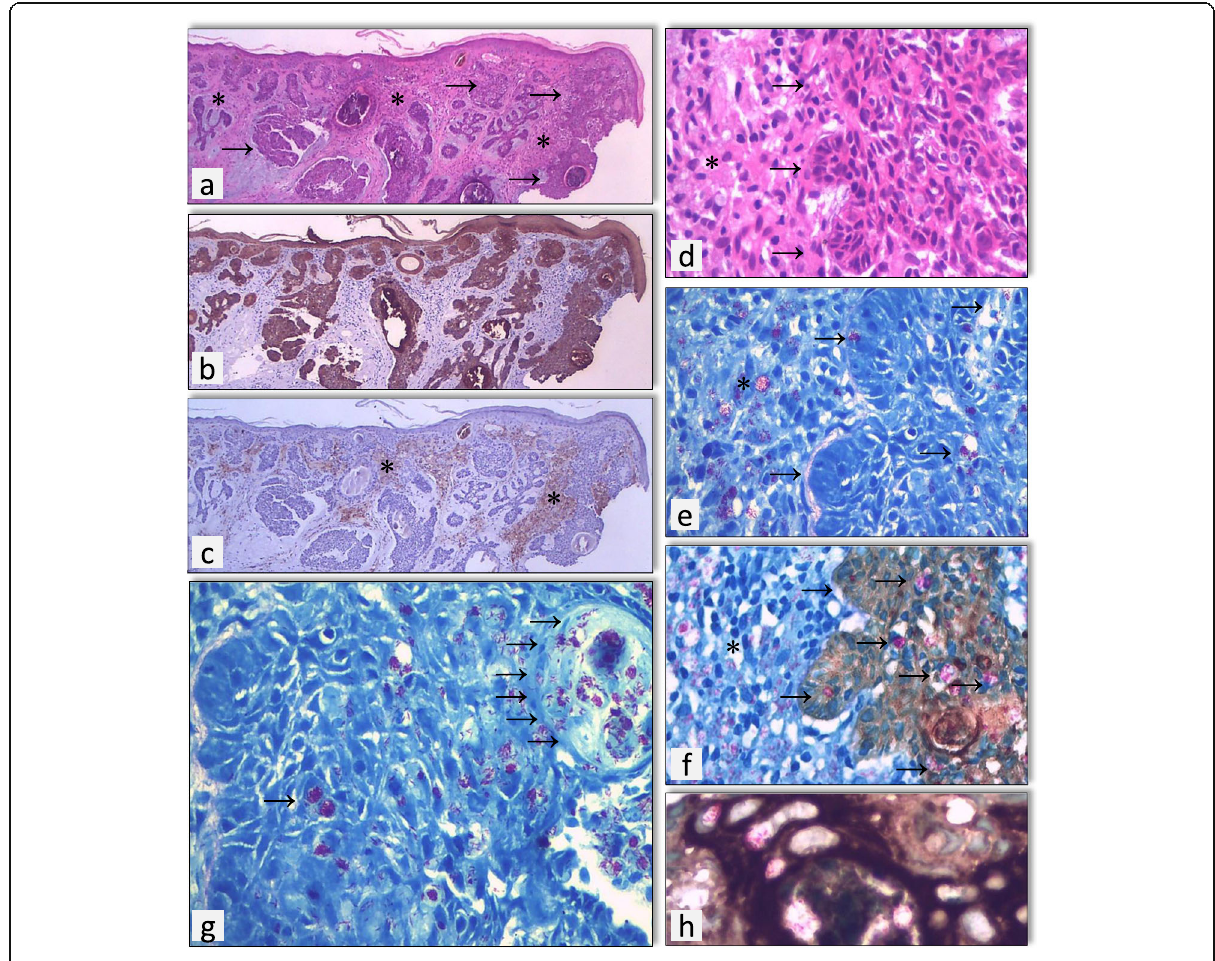
Fig. 4 Parasitism of basal cell carcinoma by M. leprae in case 3. Sequential sections stained with hematoxylin-eosin (HE) ( a ) and immunohistochemistry (IHC) ( b and c ). a Basal cell carcinoma ( → ) and adjacent leprosy lesion (*) are observed. b IHC anti-cytokeratin (34ßE12) immunostaining highlighting basal cell carcinoma ( → ) and negative leprosy lesion (*). Sequential sections stained by HE ( d ), Fite-Faraco (FF) ( e ), and IHC ( f ). d Left: lepromatous lesion (*); right: basal cell carcinoma ( → ). e Bacilloscopy of the histological sections (FF) shows numerous bacilli inside the macrophages (*) and in vacuoles of basal cell carcinoma cells ( → ). f and h Positive double staining (IHC-34ßE12 and FF) for basal cell carcinoma ( → ) and negative for the leprosy lesion macrophages (*), both containing bacilli in the cytoplasm. g FF staining showing large numbers of bacilli in intracytoplasmic vacuoles of basaloid cells and also in areas of formation of horny pseudocysts ( →